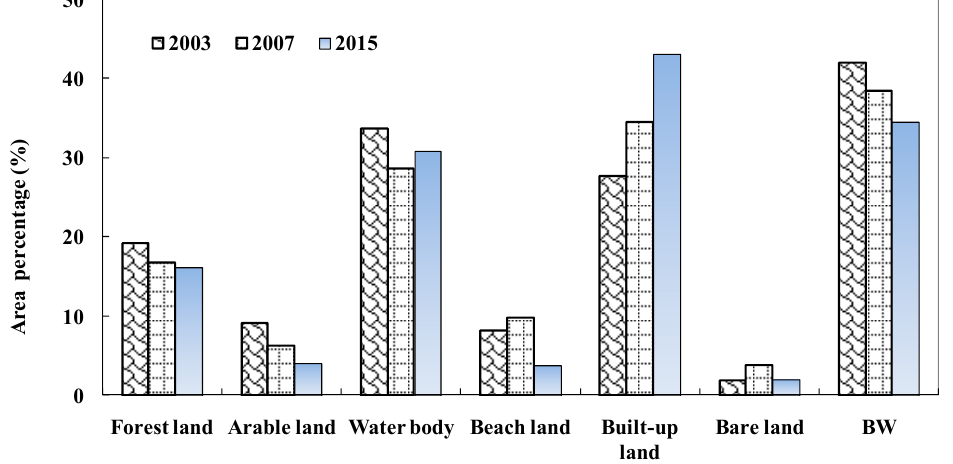
Figure 10. LULC changes in the study area from 2003 to 2015. Note: BW is the sum of beach land and water bodies.